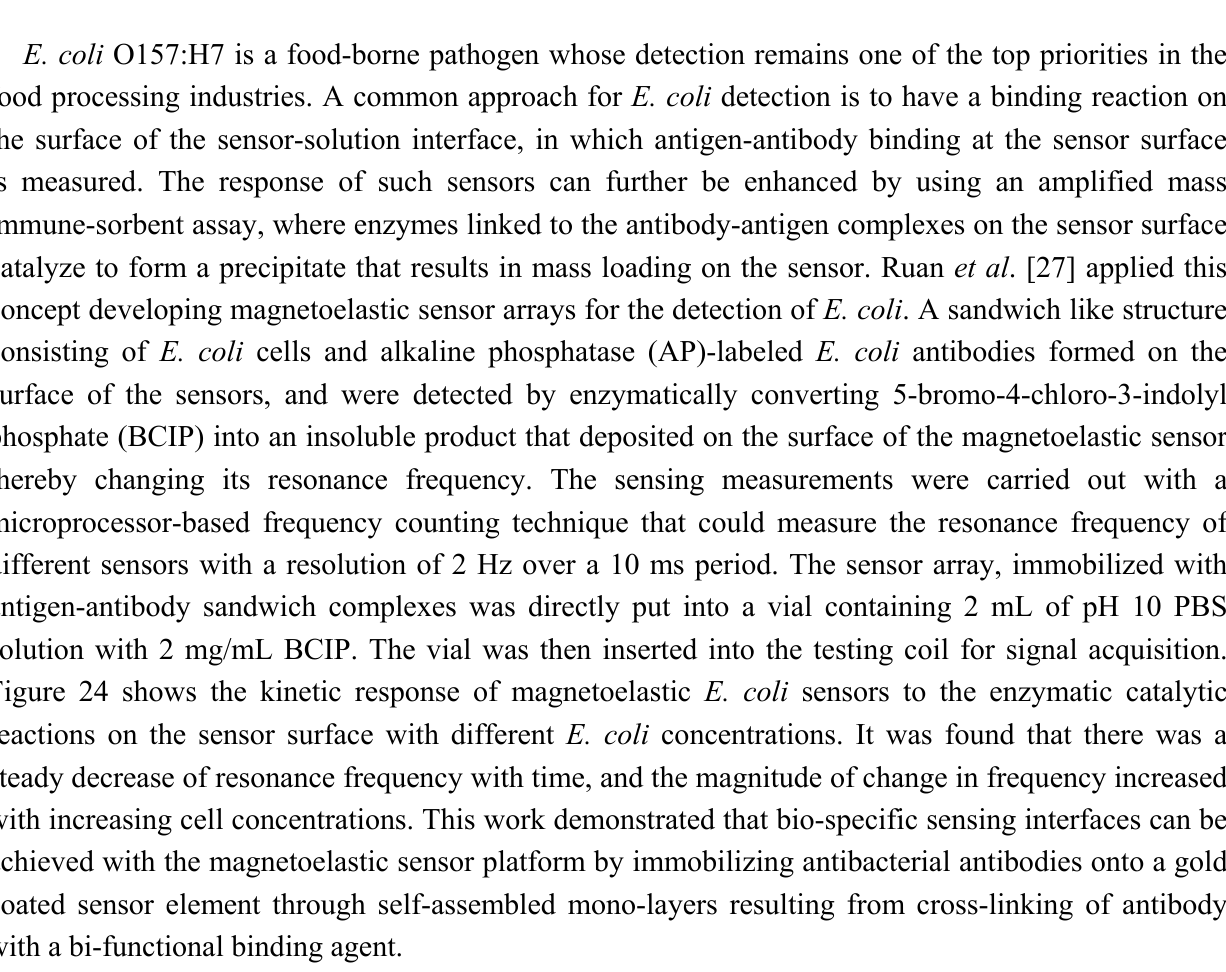
Figure 24. Shift in resonance frequency with time for a magnetoelastic sensor exposed to different concentrations of E. coli O157:H7 . Reprinted with permission from